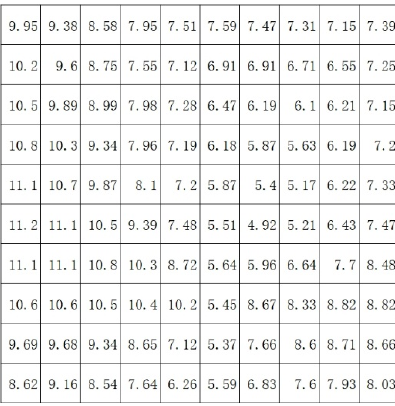
Figure 3. TOPSIS score for part of the grid.